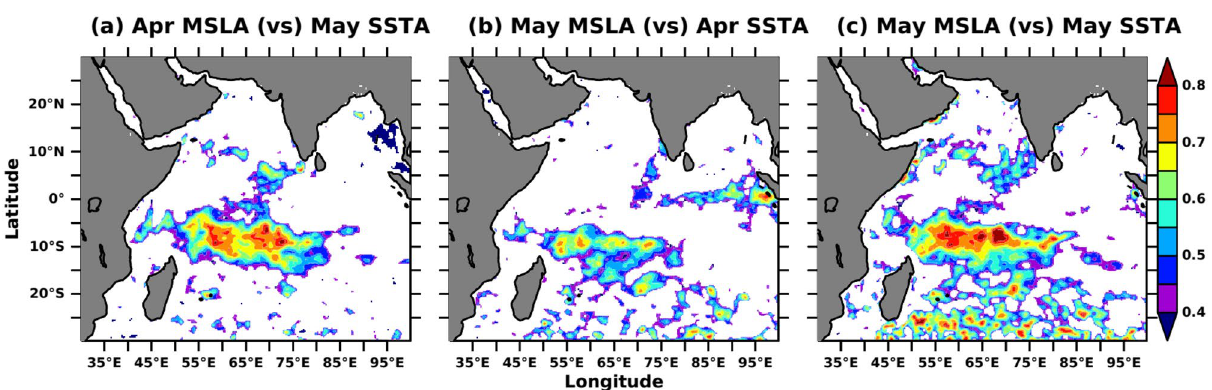
Figure 5. Lagged and simultaneous correlation of detrended SSTA and detrended MSLA during April–May in the study period. Areas with 95% significant correlations are shown. The figure is generated using PyFerret